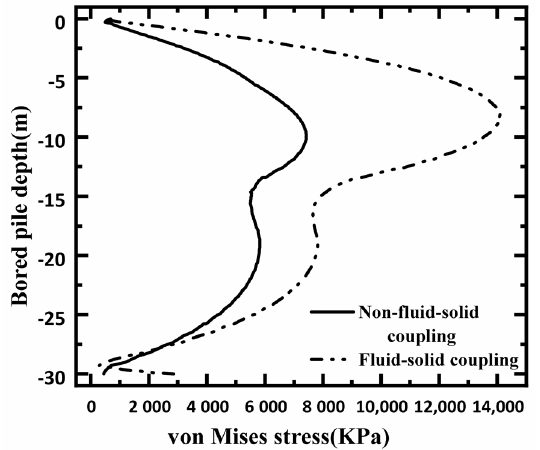
Figure 3. von Mises stress diagram of bored pile.